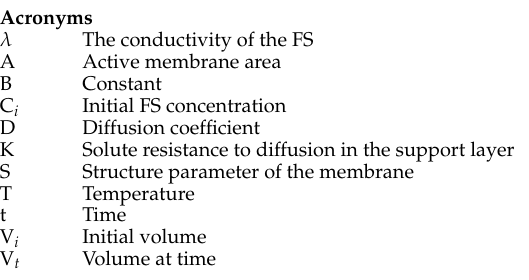
Fig. 8. Average water flux at different membrane orientation mode (T= 25 0 C, feed solution: distilled water, draw solution: 1 M ascorbic